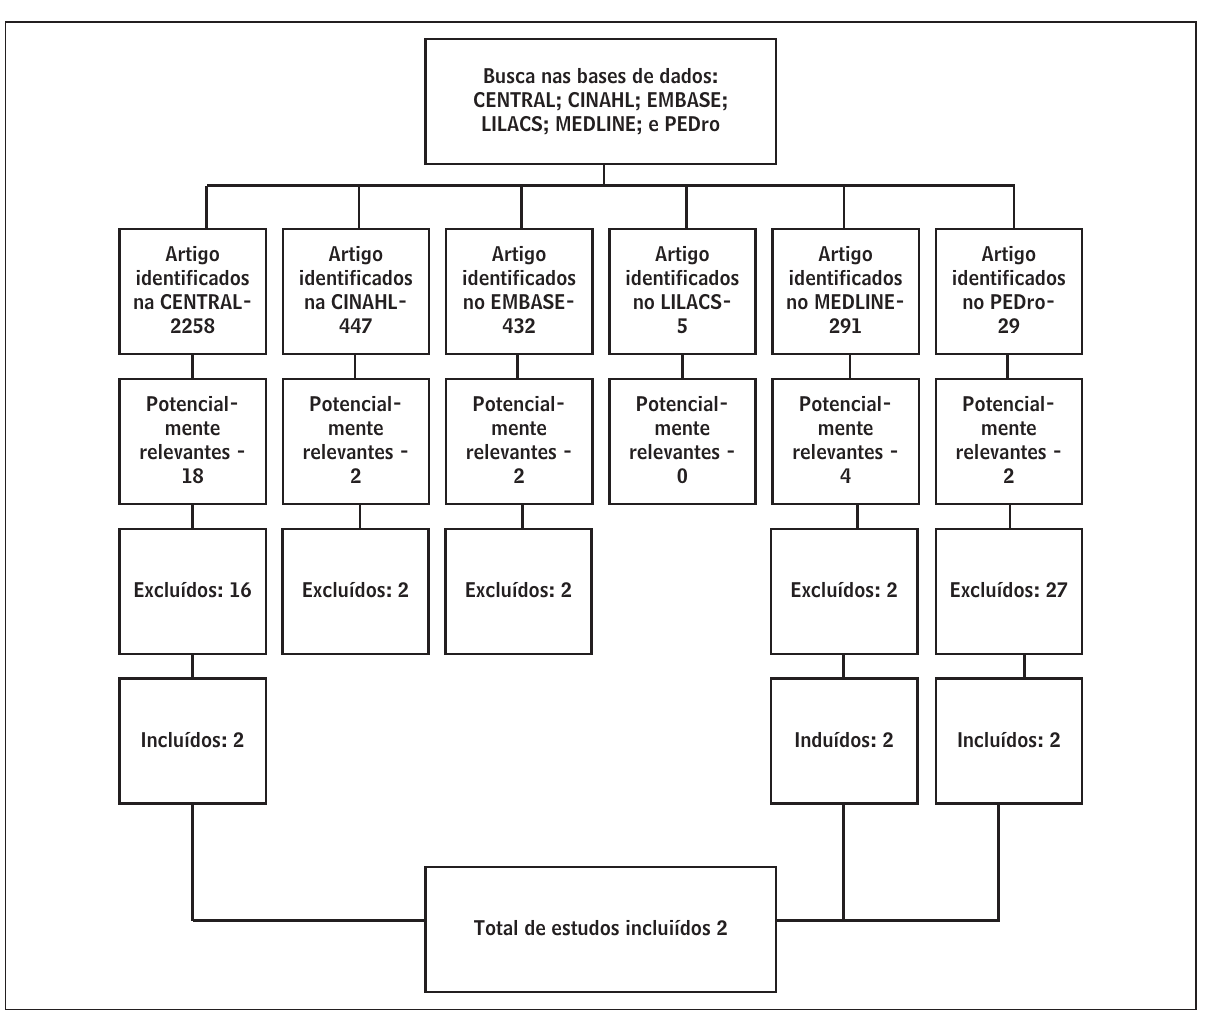
Figura 1 - Fluxograma de seleção dos estudos Fonte: Dados da